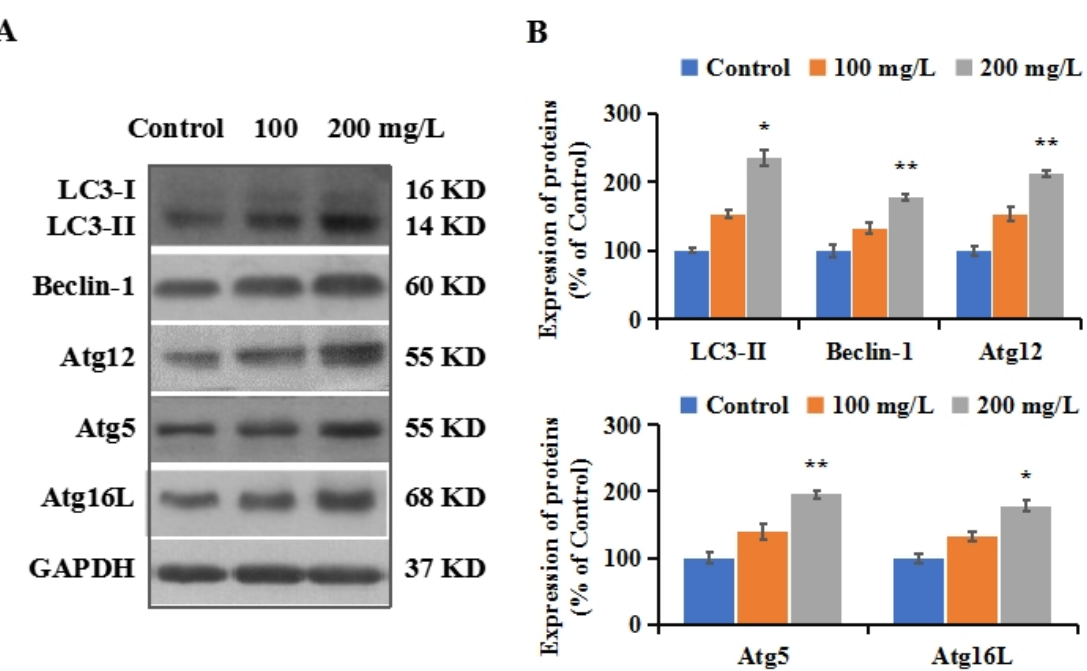
Figure 3. The autophagy induced by PS-NPs in SHSY-5Y cells. After the treatment of 100 and 200 mg/L of PS-NPs for 24 h. ( A ): The expressions of autophagy-related proteins including LC3-II, Beclin-1, Atg12, Atg5, and Atg16L were measured with Western blotting. ( B ): The expressions of proteins were quantified. In the control group, SHSY-5Y cells were only treated with medium. * p < 0.05 and ** p < 0.01, compared to the control.